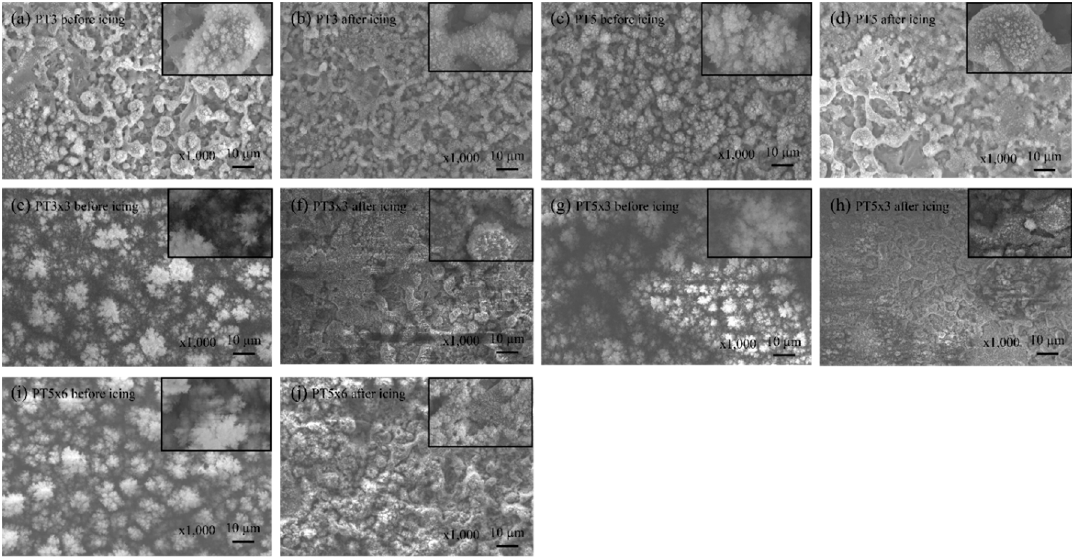
Figure 10. Scanning electron microscope (SEM) images of the plasma-deposited coatings before and after icing / deicing cycles (insets are taken with × 10,000 magnification to better show the surface structure): ( a ) PT3 before icing, ( b ) PT3 after icing, ( c ) PT5 before icing, ( d ) PT5 after icing, ( e ) PT3x3 before icing, ( f ) PT3x3 after icing, ( g ) PT5x3 before icing, ( h ) PT5x3 after icing, ( i ) PT5x6 before icing,